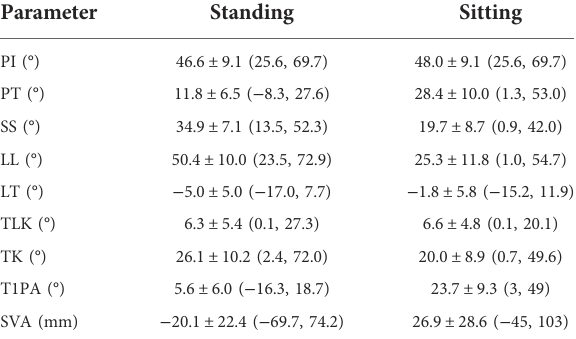
TABLE 2 Spinopelvic parameters in standing and sitting positions [mean±SD (min-max)]. Parameter Standing